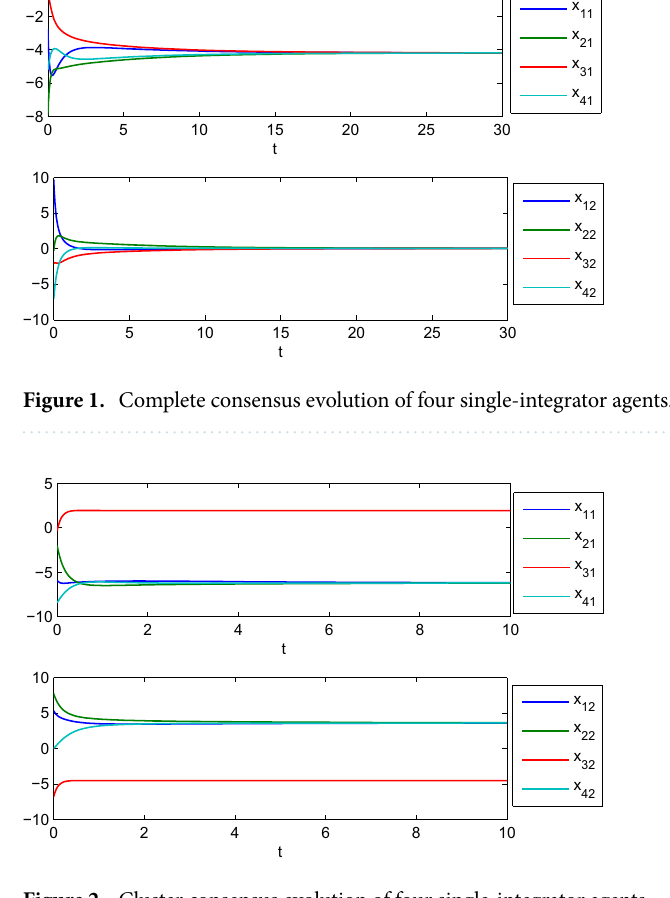
Figure 2. Cluster consensus evolution of four single-integrator